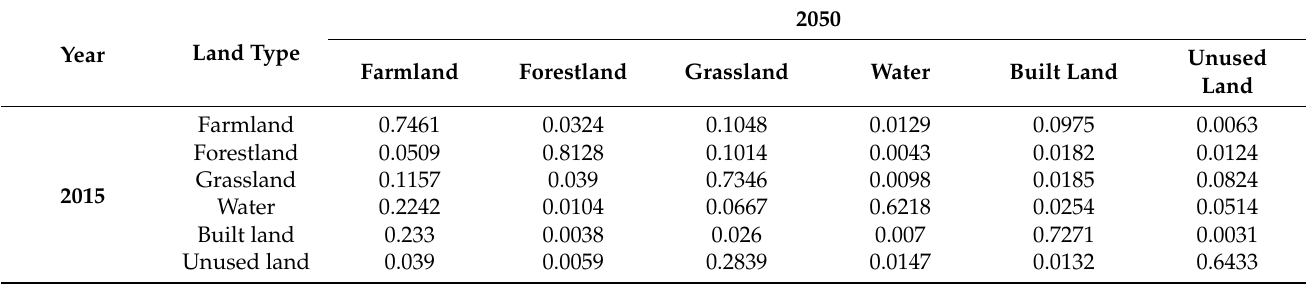
Table 5. The probability transfer matrix of land use from 2015 to 2050 under the status quo continuation